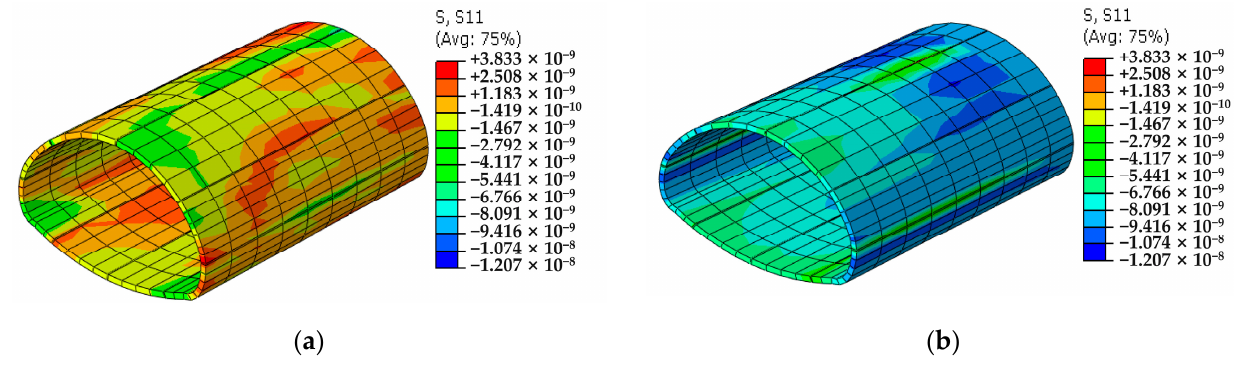
Figure 25. The horizontal stress of the secondary lining (unit: Pa): ( a ) Condition 1 and ( b ) Condition